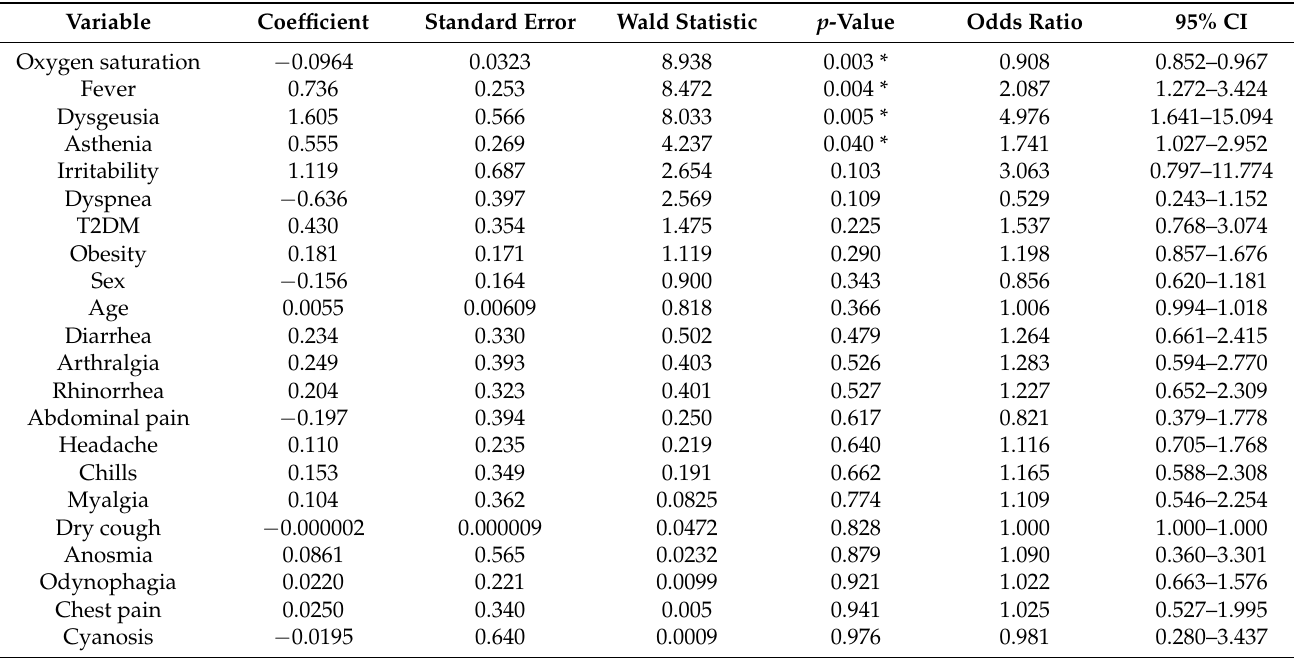
Table 3. Variable modeling by multivariate logistic regression analysis.